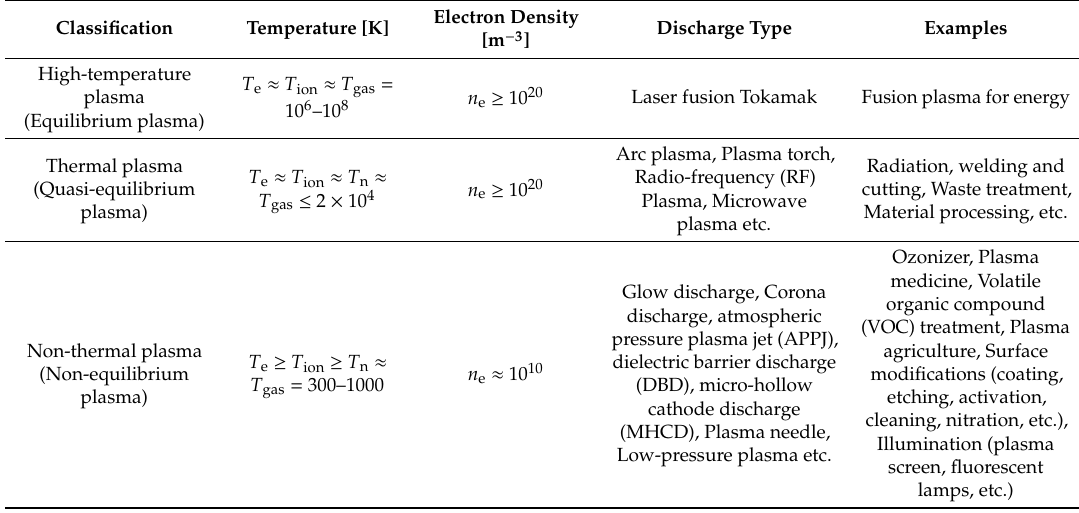
Table 1. Typical classification of plasma